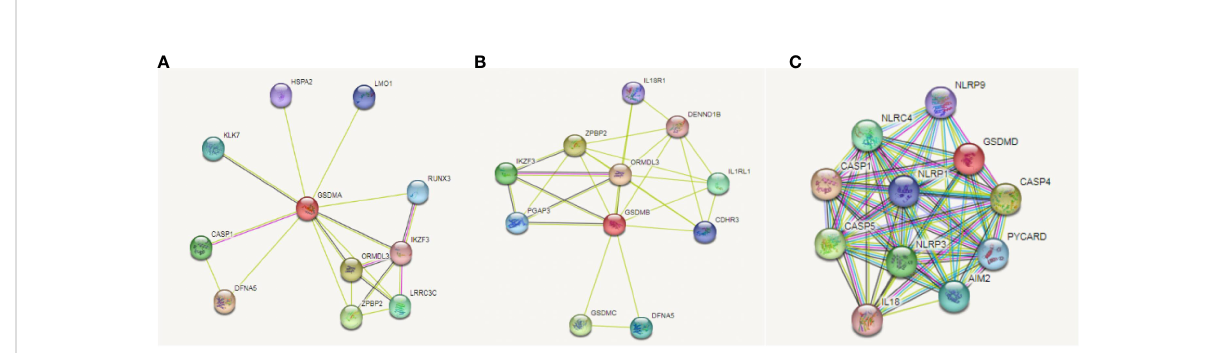
FIGURE 7 Correlation between GSDMs and immune check-points related genes in LUAD. We used the STRING database to analyze the correlation between GSDMA (A) , GSDMB (B) , and GSDMD (C) and immune related